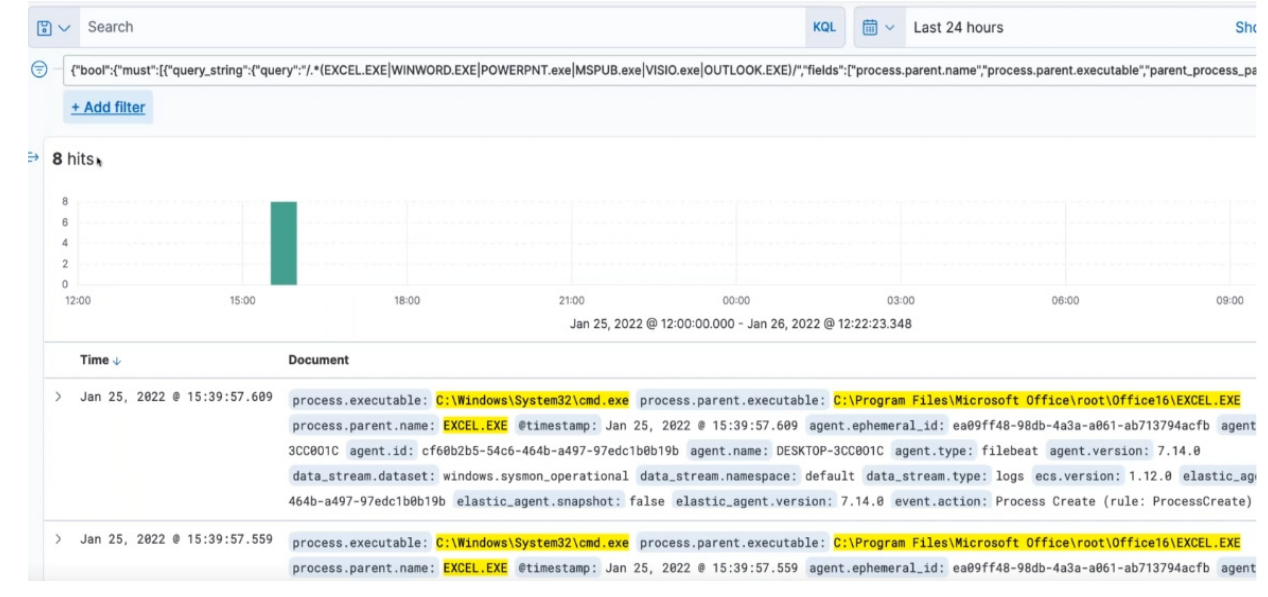
Figure 5. ( a ) Elastic Endpoint Sysmon. ( b ) Elastic Endpoint Sysmon script.